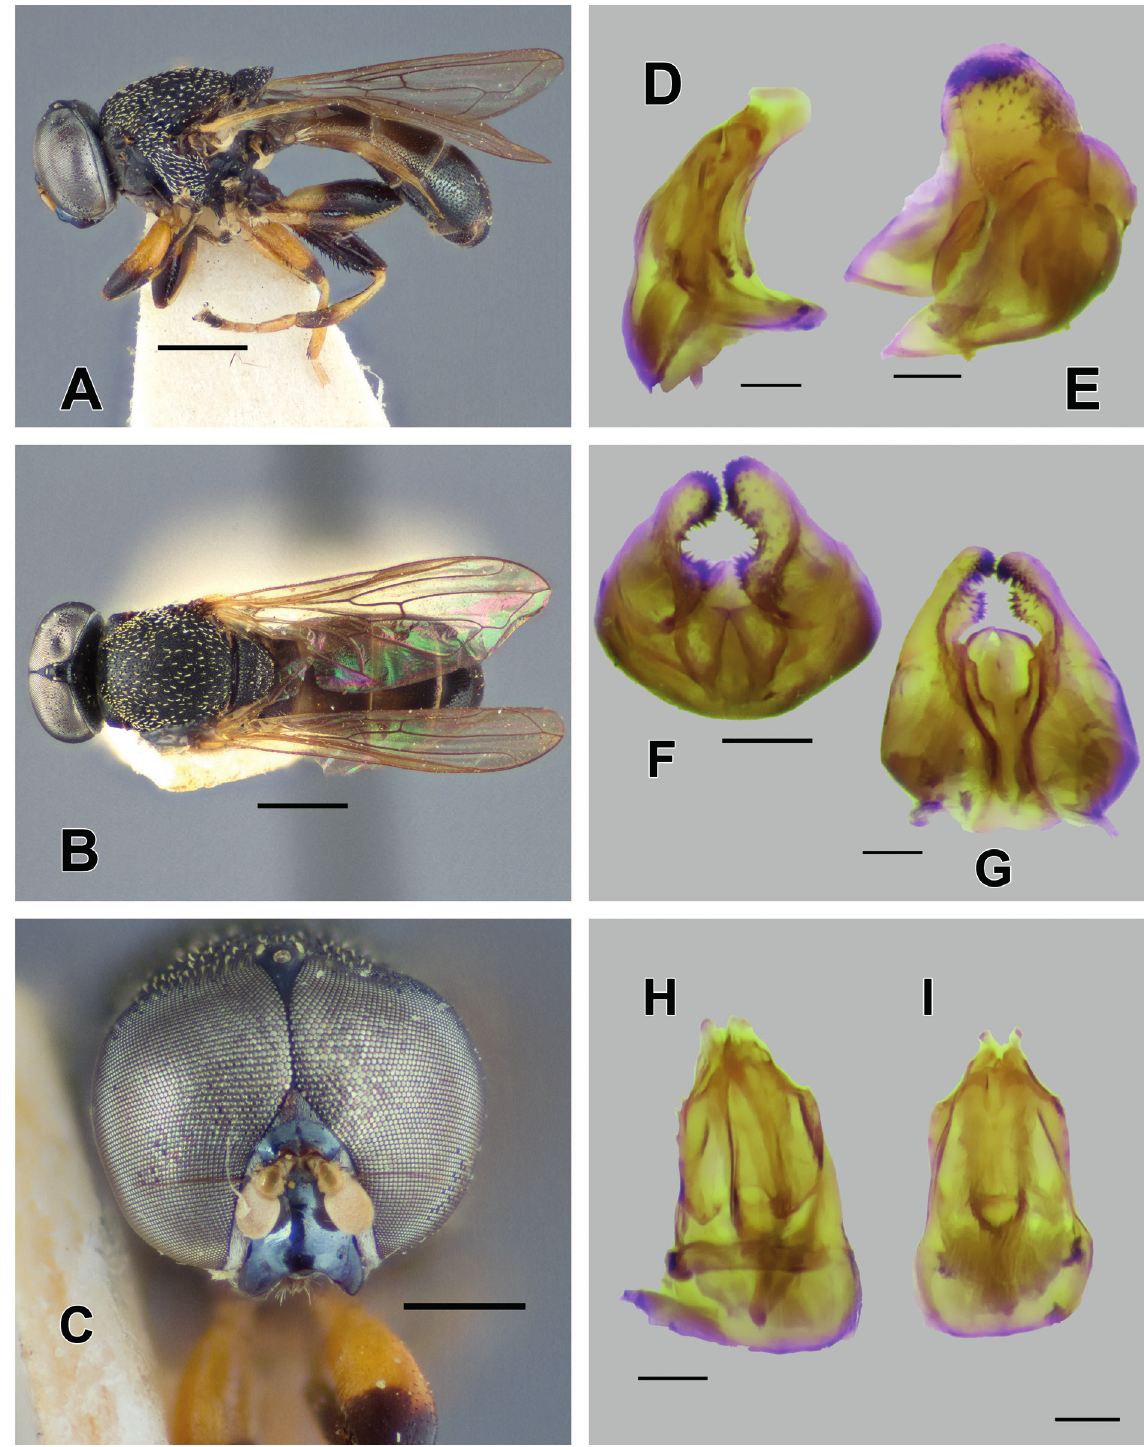
Fig. 5. Myolepta iota sp. nov., ♂, holotype (ZFMK-DIP-00082514). A . Habitus, lateral view. B . Habitus, dorsal view. C . Head, frontal view. D . Genitalia, hypandrium, lateral view. E . Genitalia, epandrium, lateral view. F . Genitalia, epandrium, dorsoposterior view. G . Genitalia, epandrium, ventral view. H . Genitalia, hypandrium, dorsal view. I . Genitalia, hypandrium, ventral view. Scale bars: A–B = 1 mm; C = 0.5 mm; D–I = 0.1